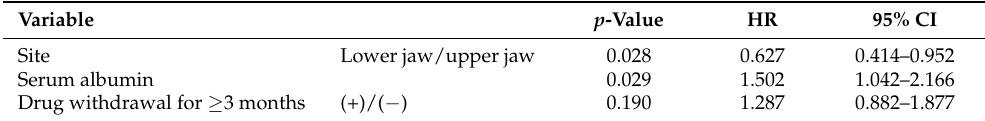
Table 5. Factors related to healing rate of MRONJ by multivariate analysis of 139 patients undergoing surgical therapy.